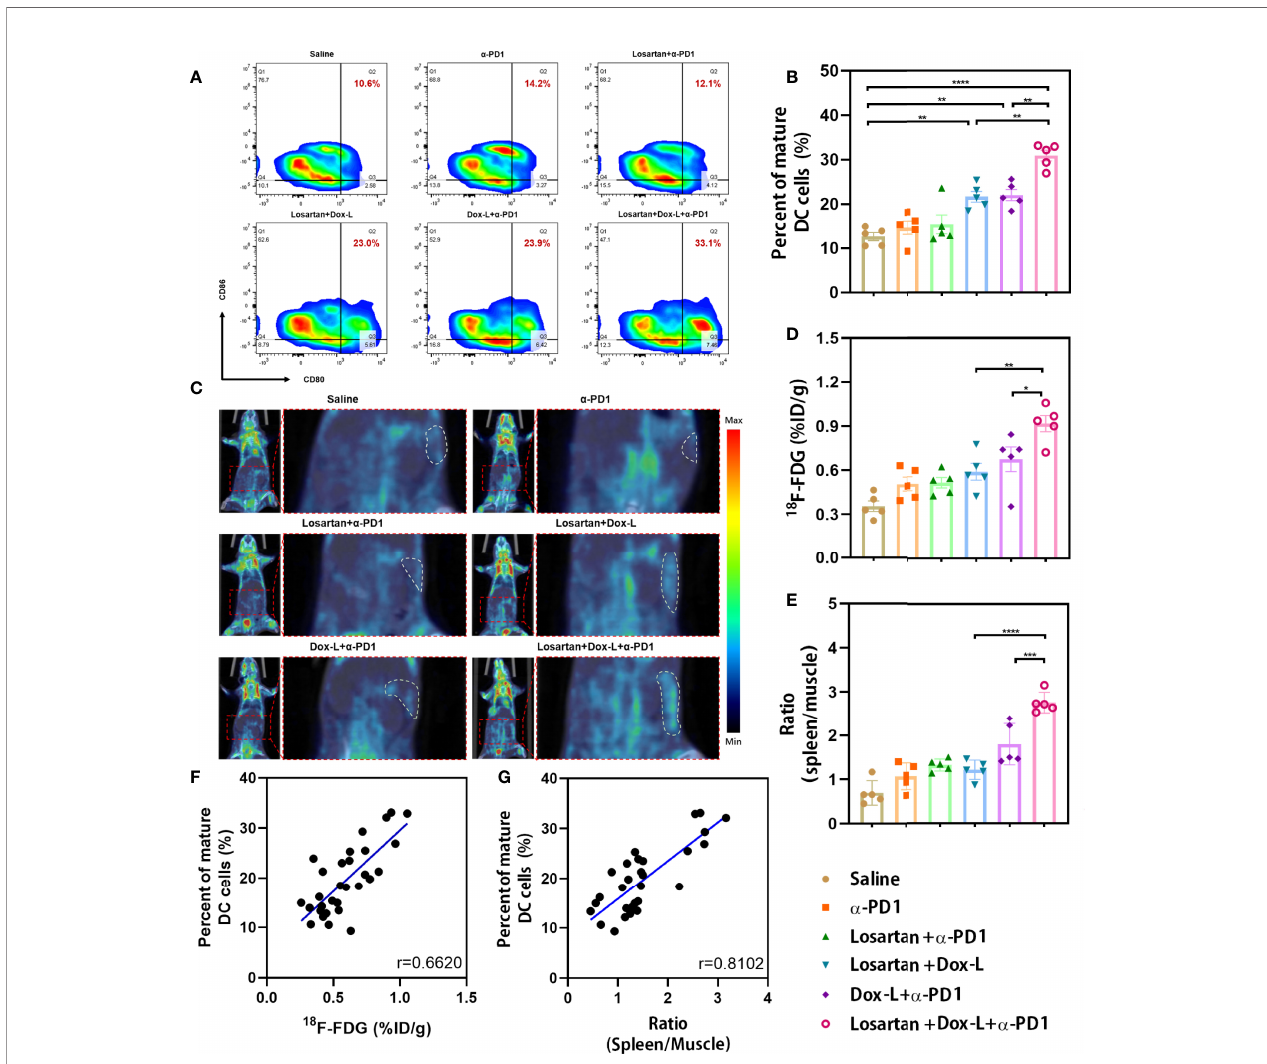
FIGURE 5 | Investigation of the splenic DCs in fi ltrate and splenic 18 F-FDG uptake in mice bearing 4T1 tumors after combination therapy. (A, B) The percentage of mature DCs (CD11c+, CD80+, CD86+) was analyzed by fl ow cytometry (n = 5). (C) Representative PET/CT images showing the 18 F-FDG uptake in the spleens of 4T1 tumor-bearing mice at PET scans (n = 5). White dashed line = spleen. (D) Splenic 18 F-FDG uptake was determined by scanning in 4T1 tumor-bearing mice. (E) The ratio (spleen/muscle) is expressed as decay-corrected mean SUV of ROI of spleen divided by decay-corrected mean SUV of ROI of muscle. (F, G) Correlation of the 18 F-FDG uptake and the ratio (spleen/muscle) respectively with the number of splenic DC cells present. Data are expressed as the mean ± SEM. Statistical signi fi cances were calculated via one-way ANOVA using the Tukey post-test, * p < 0.05, ** p < 0.01, *** p < 0.001 and **** p <